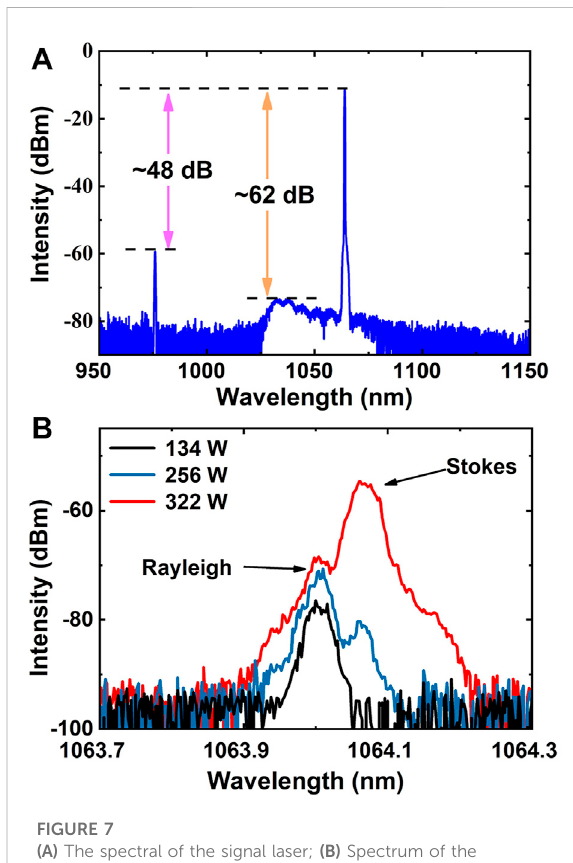
FIGURE 7 (A) The spectral of the signal laser; (B) Spectrum of the backward propagating